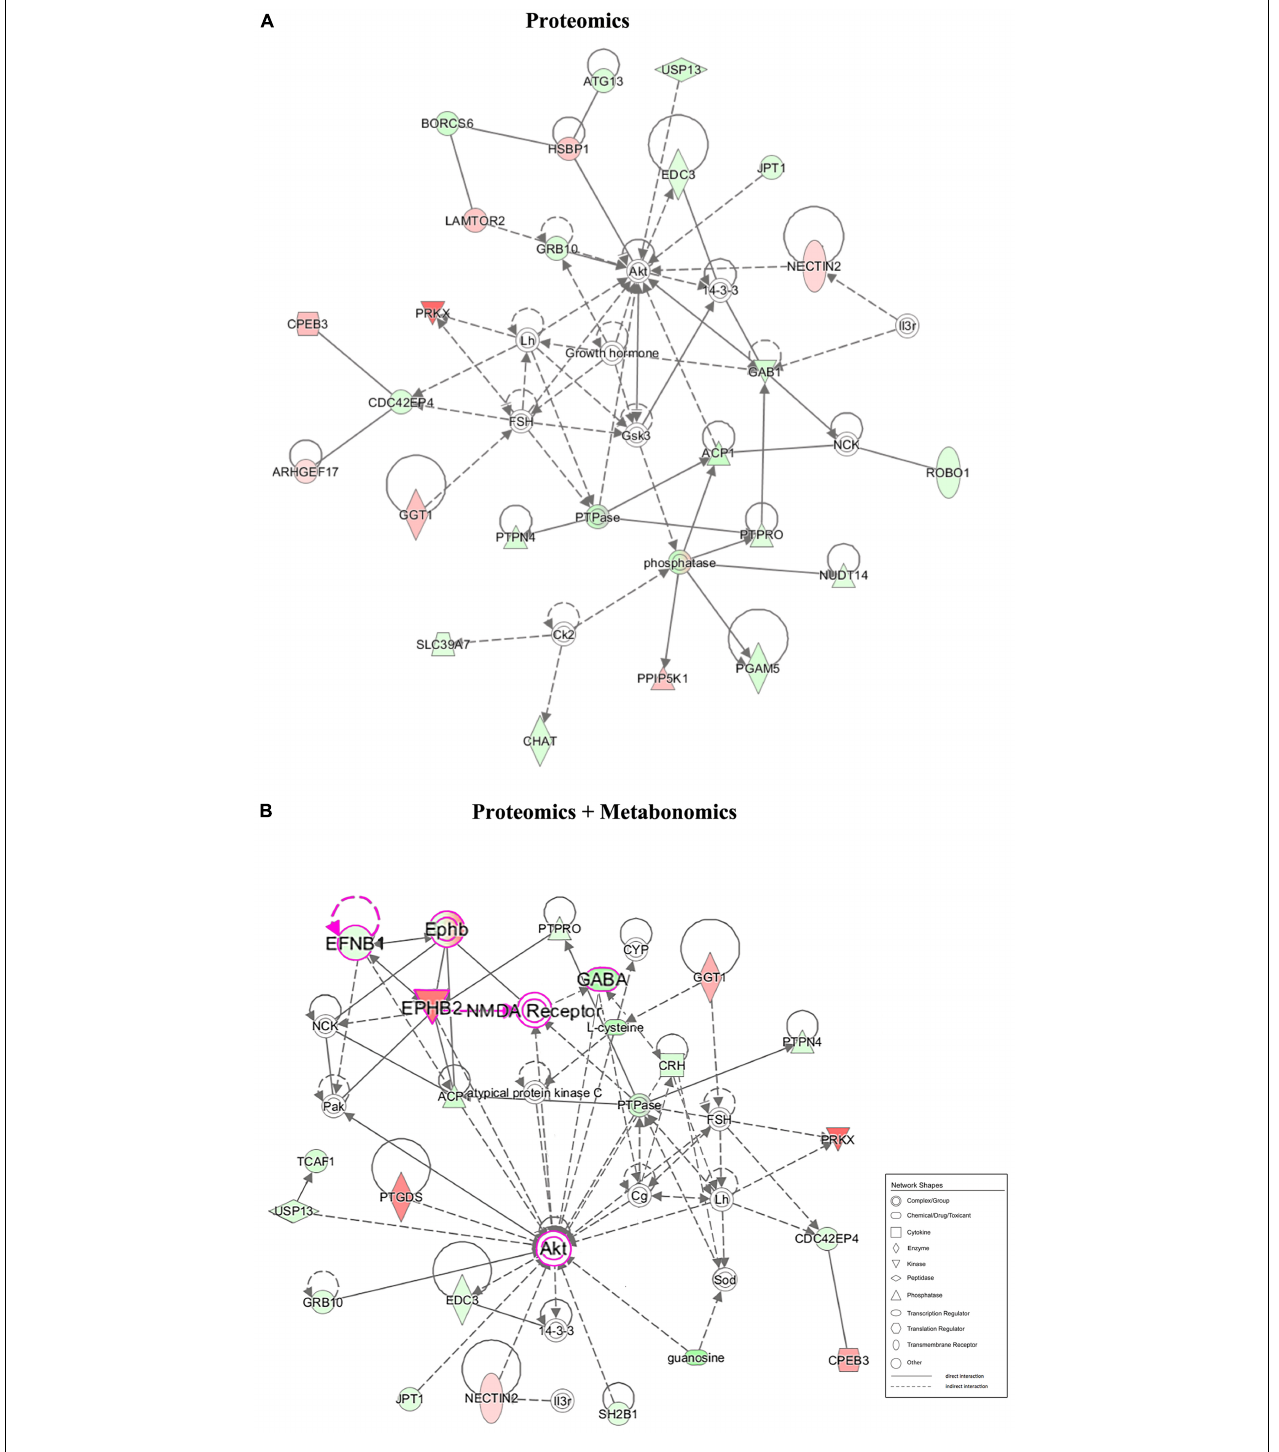
FIGURE 5 | Correlation network between the significantly changed metabolites and proteins of the hypothalamus in the LPS group compared with that in the CON group. (A) Network-based proteomics data. (B) Network-based bi-omics (proteomics + metabolomics) data. Red symbols indicate upregulation, while green indicate downregulation, in the LPS group compared with that in the CON group. The molecular interaction network was generated based on the Ingenuity Pathway Knowledge Base. The hypergeometric distribution of the network was calculated using the right-tailed Fisher’s exact test. The gray solid lines and dotted lines show direct and indirect interactions or regulations of the two groups, respectively. Nodes of different shapes represent different meanings, similar to “Network Shapes.” Pink symbols in network B indicate a possible EPHB2-NMDAR-AKT cascade in the underlying pathogenesis.